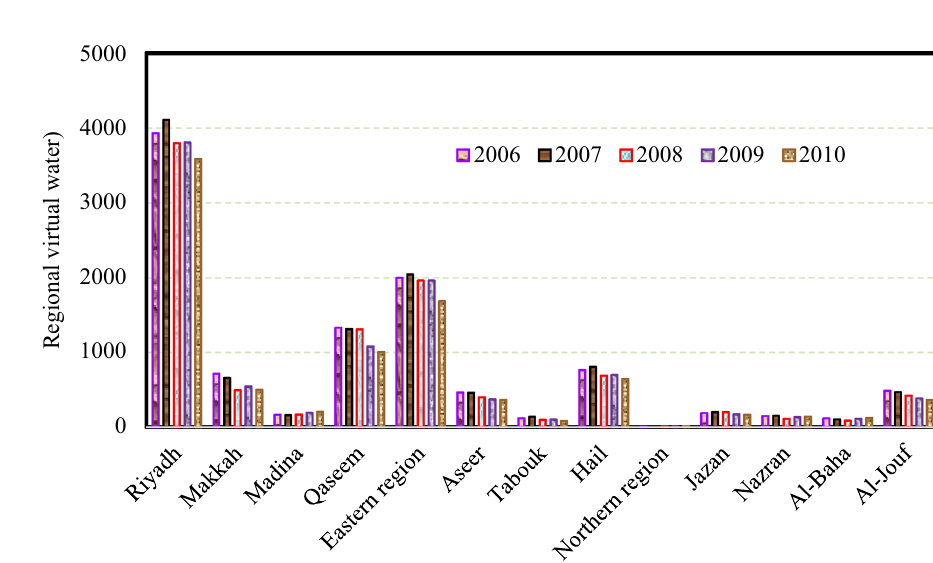
Fig. 2 Regional VWC for livestock and eggs (million m 3